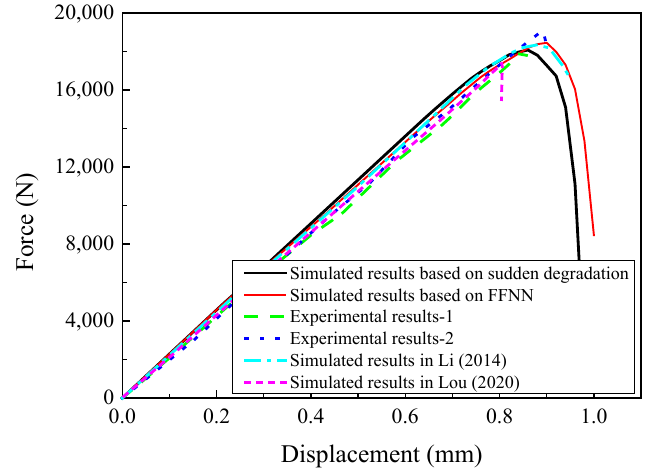
Figure 16. Predicted compressive responses of the open-hole laminates. Table 5. The comparison of the predicted strength values.